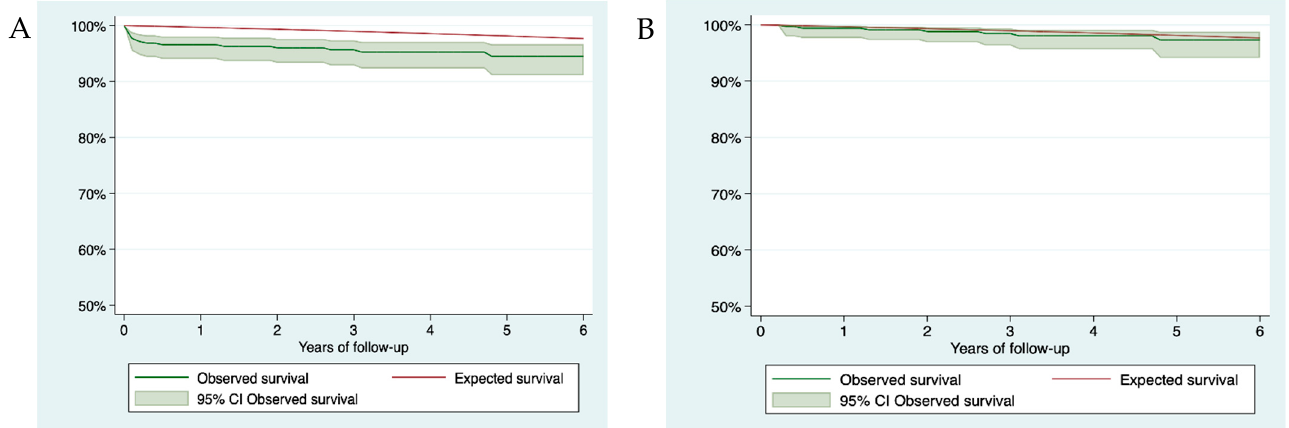
Figure 2. Survival curves ( A ) Global survival curve. ( B ) Survival curve of those alive 2 months after STEMI.